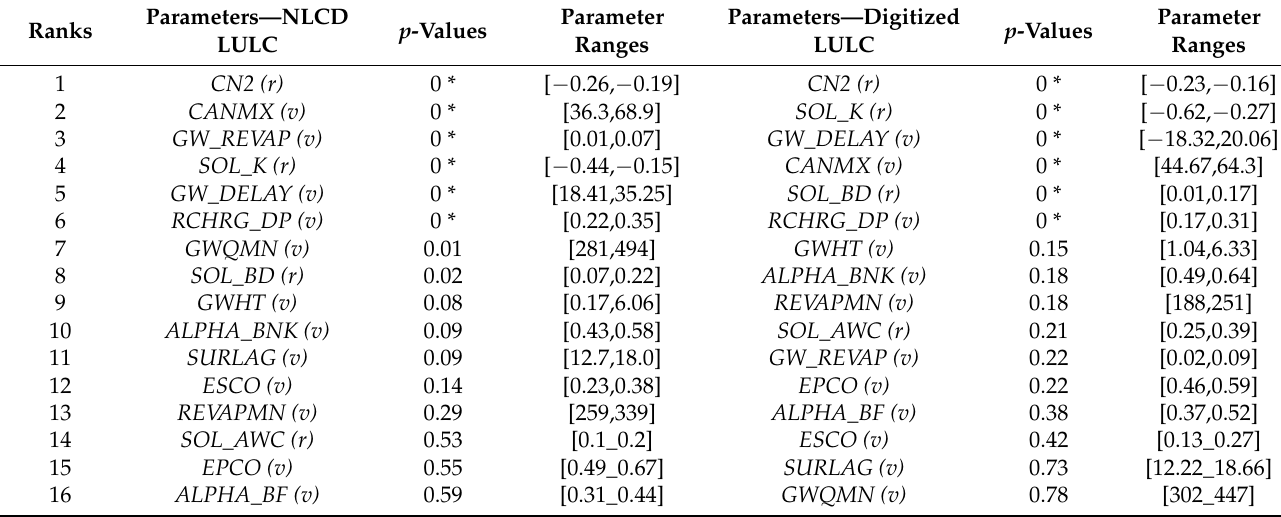
Table 6. Sensitivity ranks and p -values of two different LULC datasets. Table 7. Calibration and validation results.